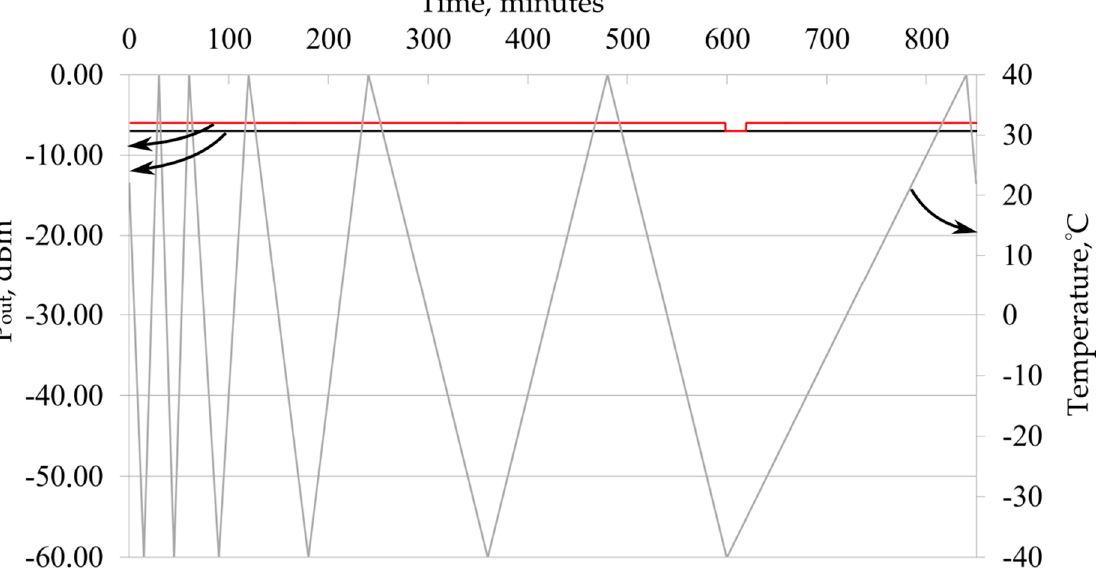
Figure 5. P out and temperature plots versus time for sample covered by conductive paste. Black and red lines are P out1 and P out2 respectively, gray line is temperature.